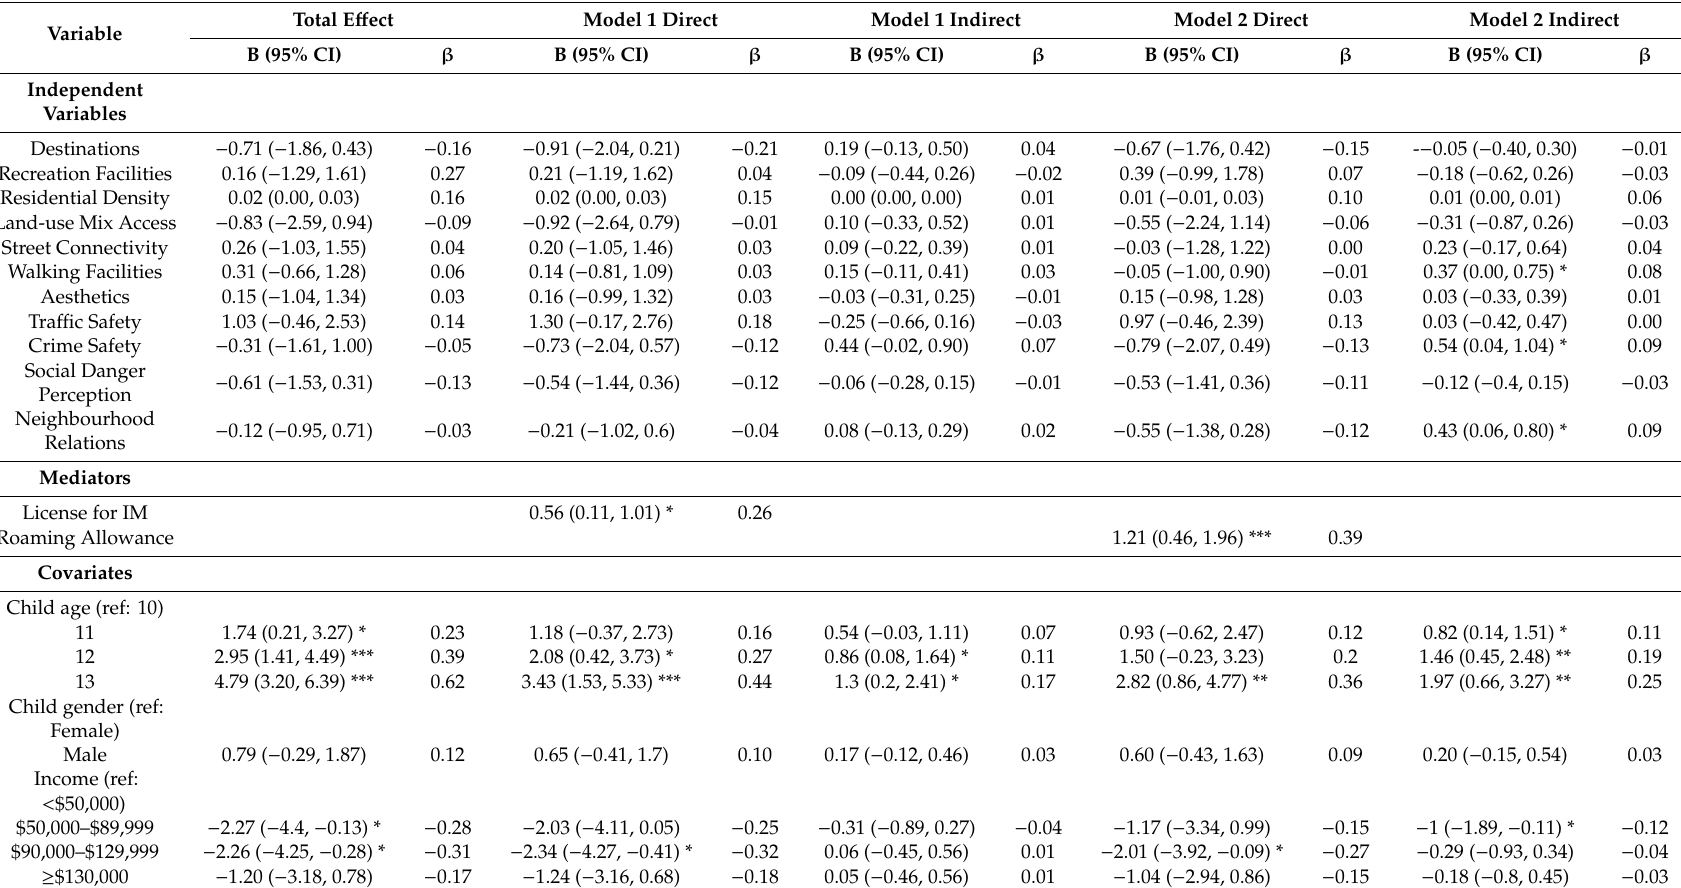
Table 4. Path coe ffi cients for territorial range area models (N =